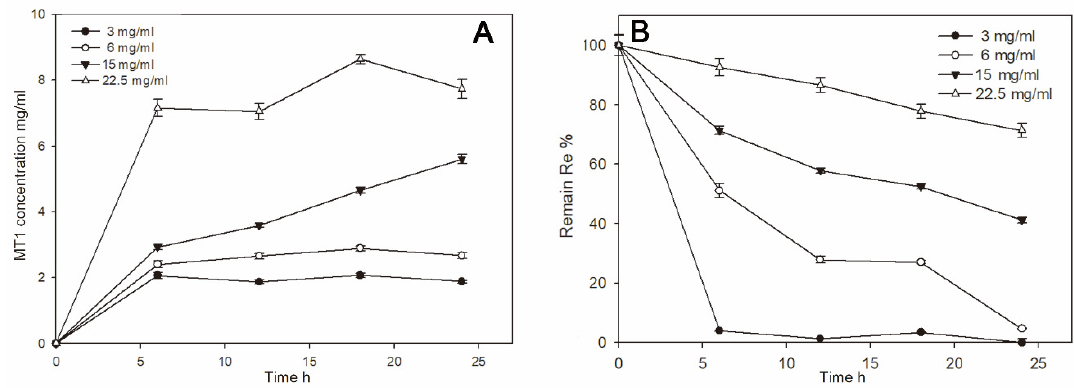
Figure 2. Effects of the substrate Re concentrations ( A ) and remaining Re concentrations ( B ) in the reaction mixture.